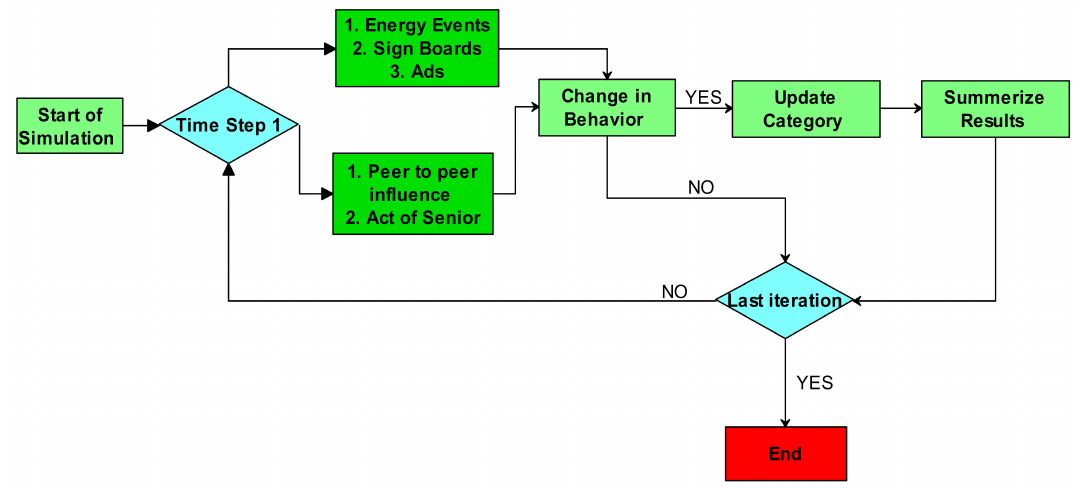
Figure 2. Simulation model